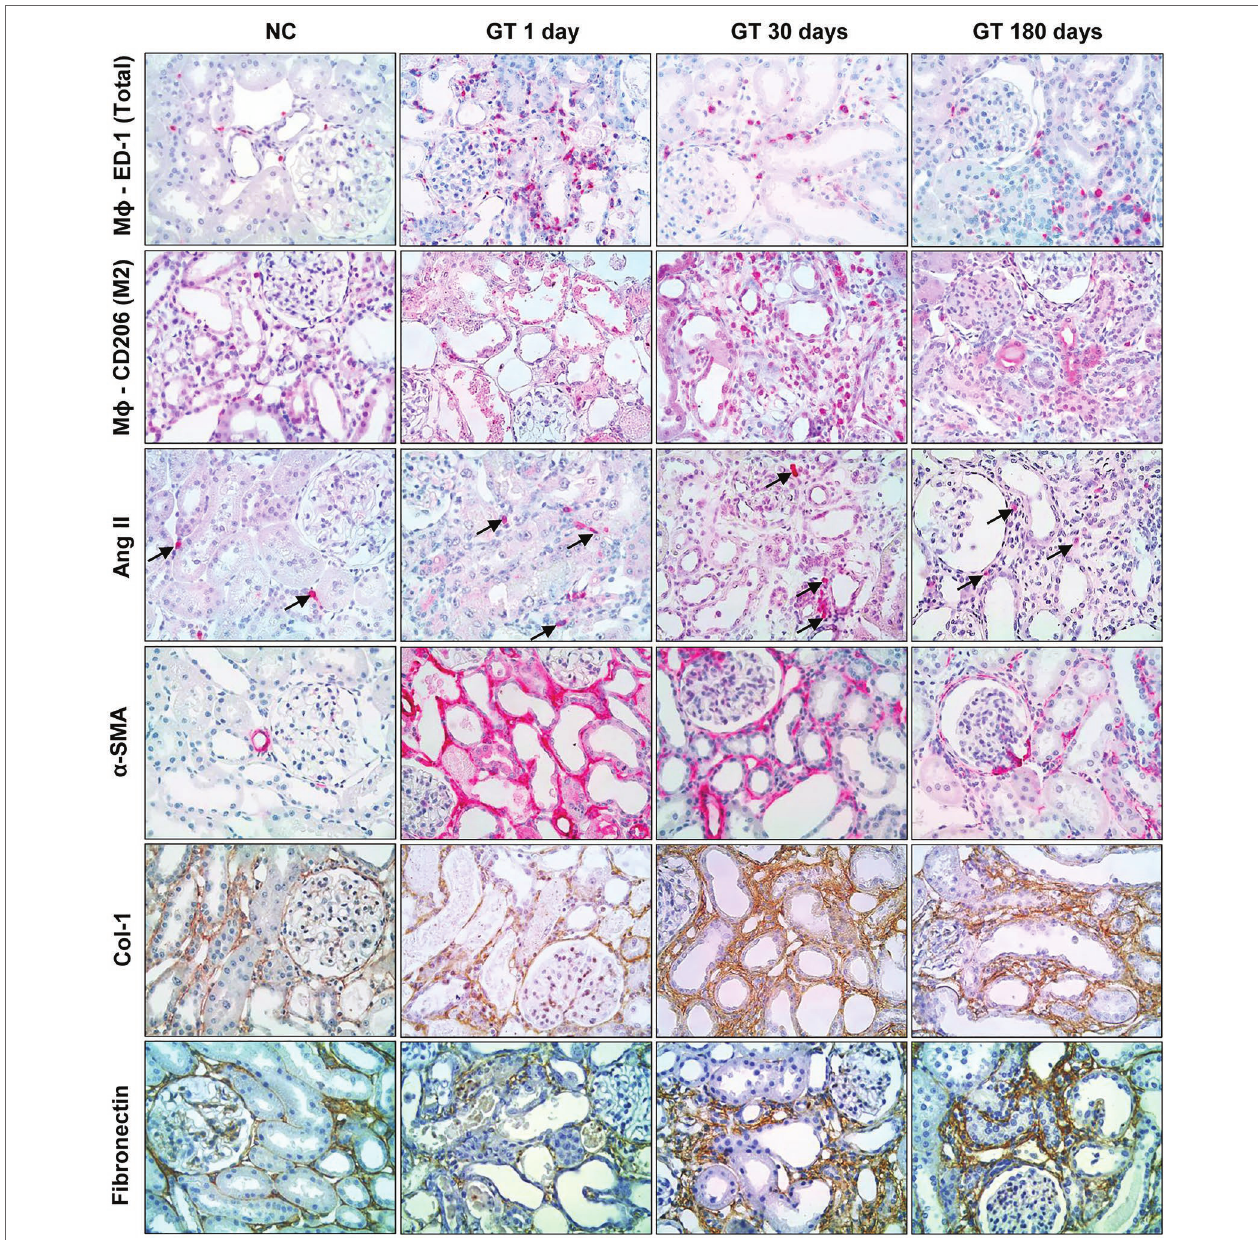
FIGURE 4 | Representative microphotographs (in immunohistochemically stained sections, 400×) of renal interstitial infiltration by total macrophages (ED-1-positive cells); M2 macrophages (CD206-positive cells); AngII-positive cells; α -SMA-positive cells; and renal interstitial deposition of Collagen-1 and Fibronectin in groups NC and GT on Days 1, 30, and